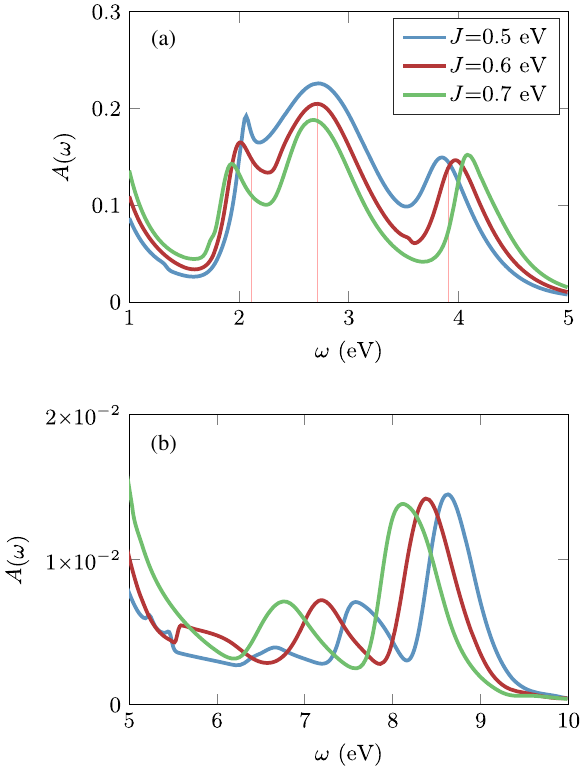
FIG. 8. (a) Close-up of the three-peak structure for various values of J . Additionally, we show vertical lines for the J ¼ 0 . 6 eV spectrum at energies ω (position of the middle peak) and M 2 J and ω − J . We see that the width of the upper at ω M þ M Hubbard band is close to 3 J . (b) Close-up of the small spectral peaks at high energies. These correspond to excitations into the N ¼ 3 sector of the atomic model (see Table I). The height of each peak can be estimated by the degeneracy of the atomic ¯ J states. Effective parameters are 0.53 eV ( J ¼ 0 . 5 eV), 0.59 eV ( J ¼ 0 . 6 eV), and 0.68 eV ( J ¼ 0 . 7 eV). They are obtained from the difference between the two peaks that are highest in energy.